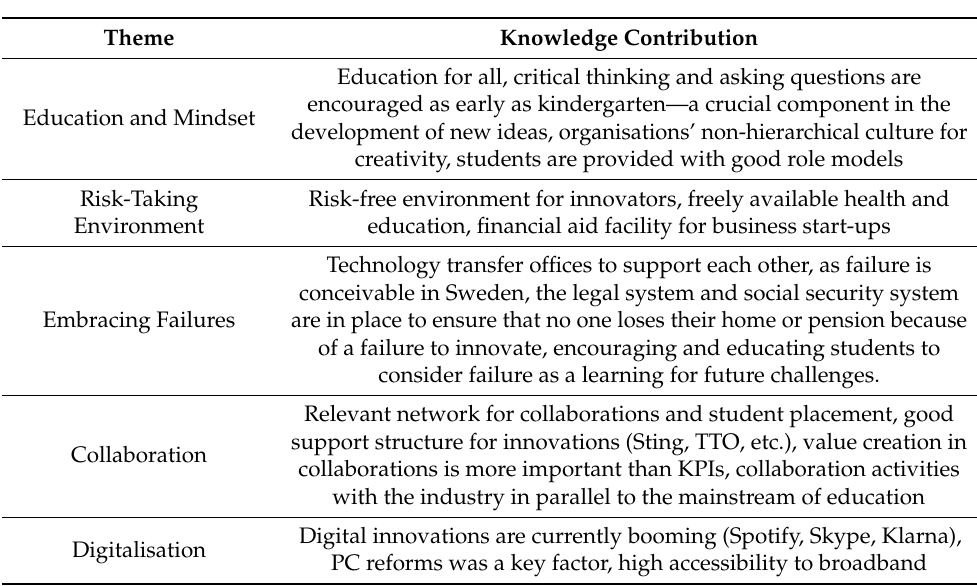
Table 2. Key findings of the